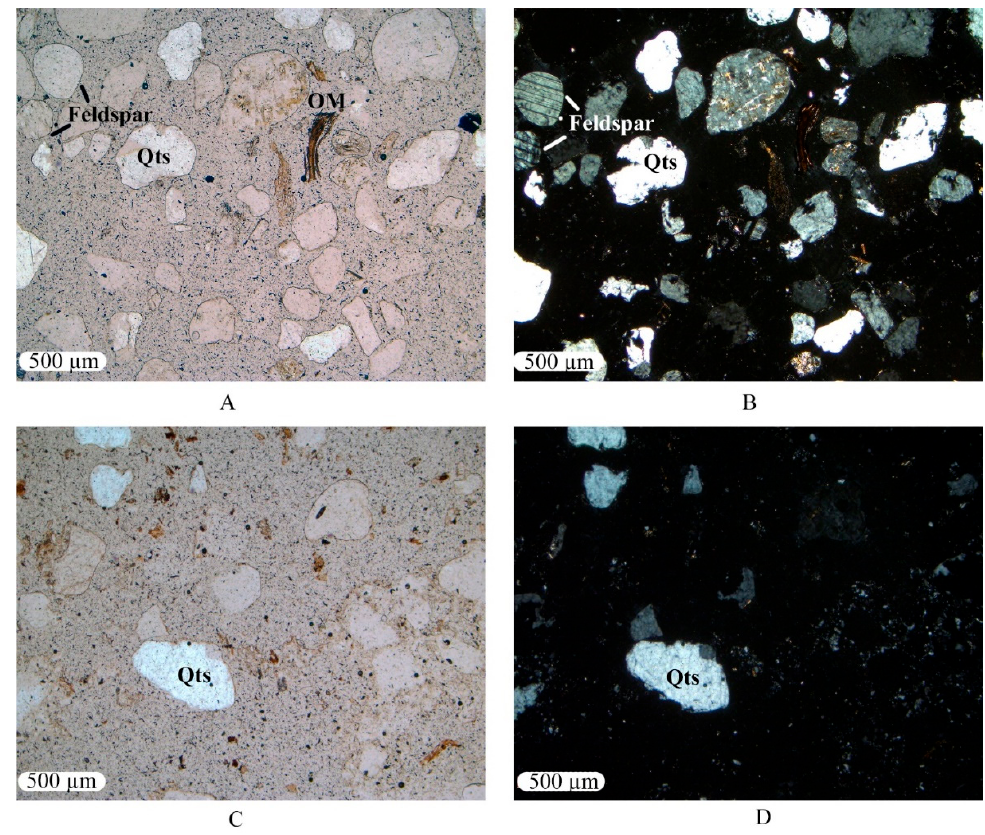
Figure 3. Micromorphological structure of the Y1 Ah ( A , B ) and Y3 Ah ( C , D ) soil profiles. ( A , C )- plane polarized light; ( B , D )- crossed polarized light. Qts-quartz; OM-organic matter.